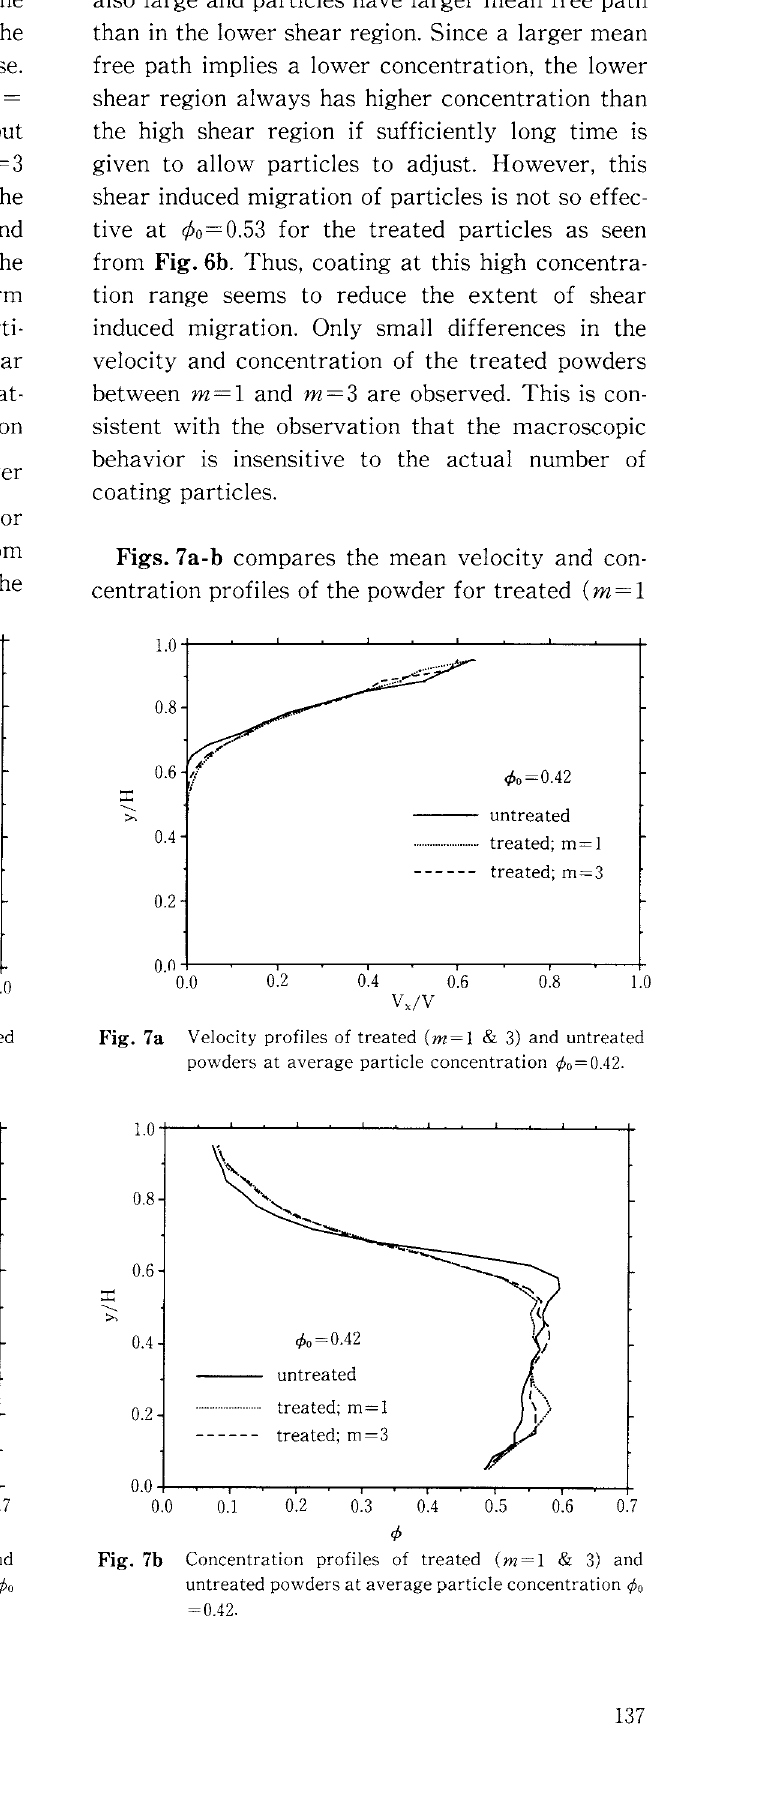
Fig. 7b Concentration profiles of treated (m=l & 3) and untreated powders at average particle concentration ¢ 0